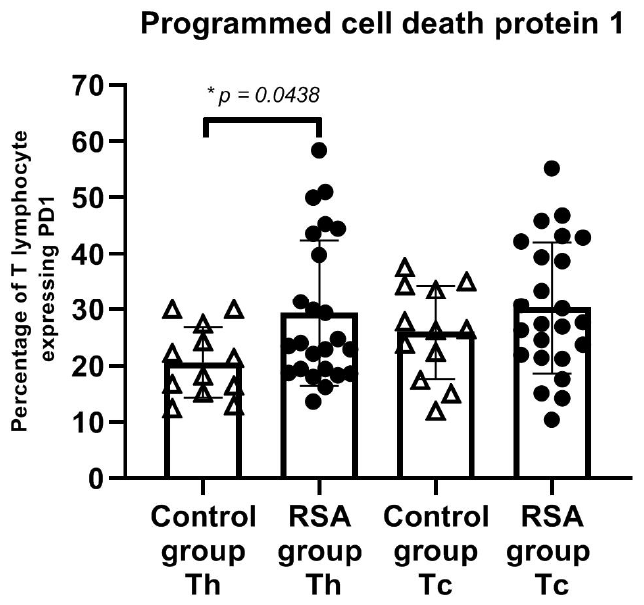
Figure 3. Expression of PD-1 on T cell subsets. A higher percentage of PD-1 expression on T helper lymphocytes was shown in the RSA group. The error bars represent the standard deviation (SD). Abbreviations: RSA group—women with recurrent spontaneous abortion, control group—healthy fertile women, Th—helper T lymphocyte (CD4+), Tc—cytotoxic T lymphocyte (CD8+), * p < 0.05 (RSA group n = 24, control group n = 12). Please refer to the Supplementary Information for gating strategy (Figures S1 and S2).